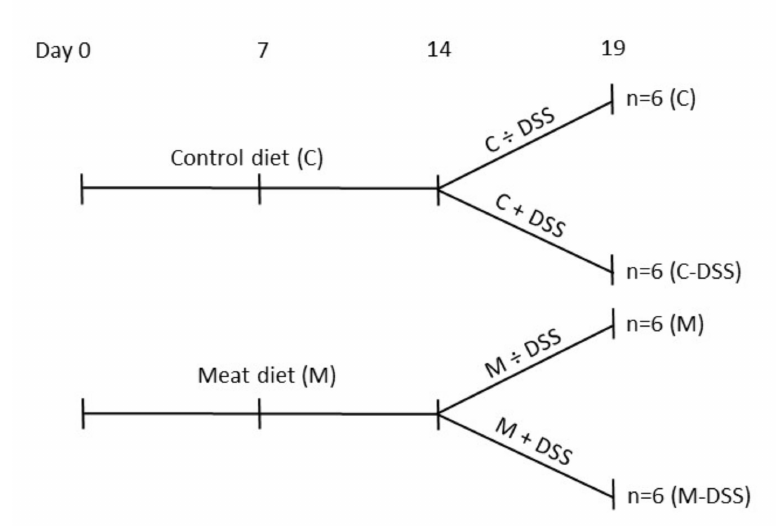
Figure 1. Overview of time-flow of the study and the four experimental treatments from day 14 to 18 (slaughter day 19); control diet (C), control diet + dextran sulfate sodium (DSS) (C-DSS), meat diet (M) and meat diet + DSS (M-DSS). Pigs were 42 days of age at experimental day